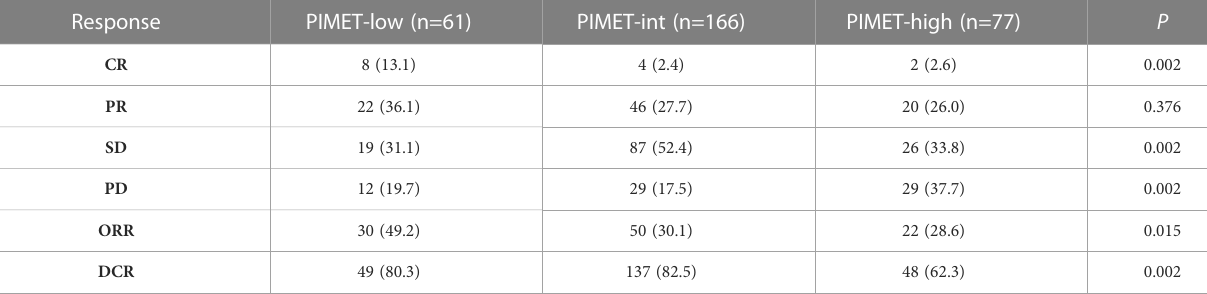
TABLE 3 Treatment responses in HCC patients with different PIMET scores.